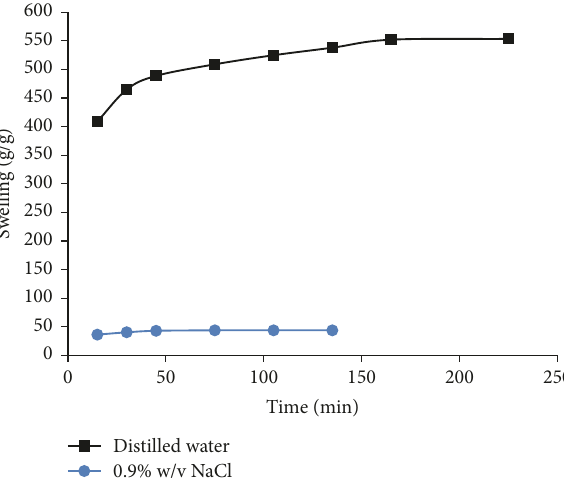
Figure 8: Effect of time on swelling capacity in distilled water and 0.9% w/v NaCl solution (reaction condition: 2.0 g/100mL NaCMC, 1.0mol/L AA, 70% neutralized AA, 0.01 mol/L MBA, and 0.014 mol/L KPS at 70 ∘ C for 90